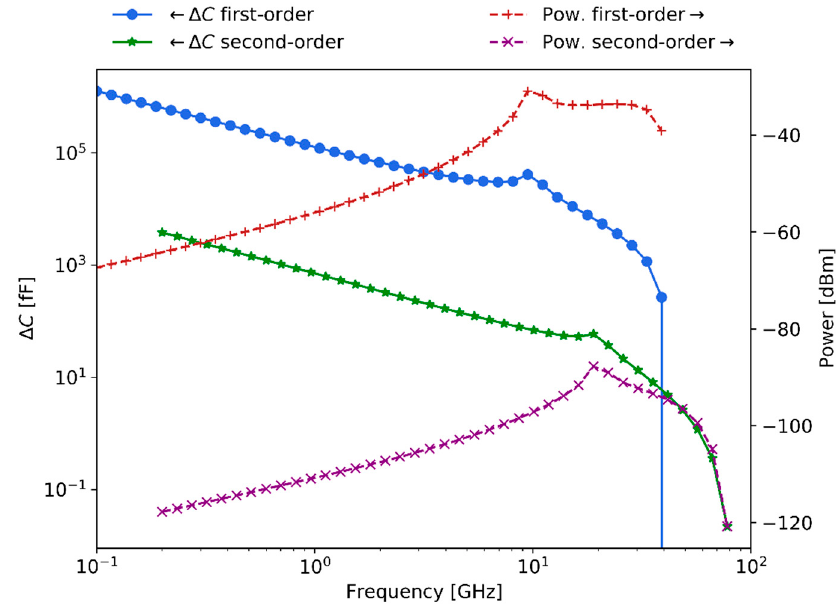
Figure 13. The signal levels regarding capacitance change and scattering levels for first-order (detection) and second-order (sensing of membrane potential) for 10 μm -sized bio-particles.